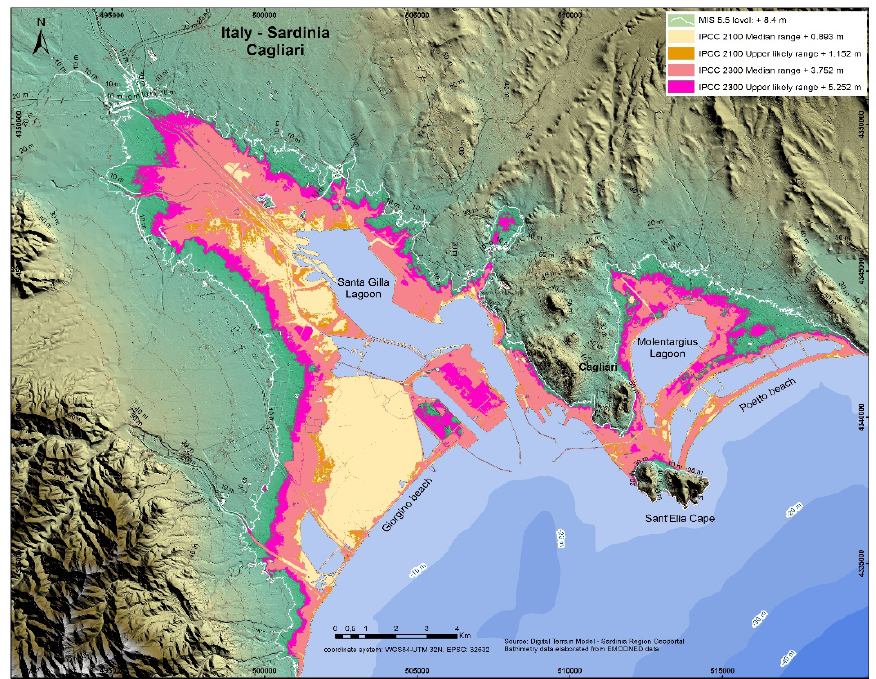
Figure 17. Map of Cagliari plane, (see also Figure 2 for location). The potential submersion area, using IPCC AR5 RCP 8.5 projections at 2100 and 2300.